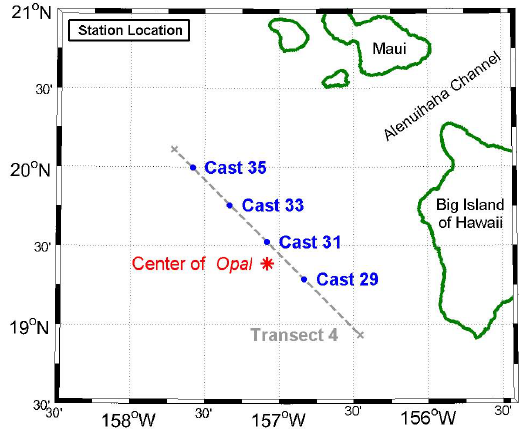
Fig. 2. Position of the four casts used in this study, and location of the estimated center of the eddy, Opal , at the time the casts were collected. The dashed line indicates the vertical section shown in Fig. 3. Notice that the position of the eddy center has changed from Fig. 1, due to Opal ’s migration (see Dickey et al., 2008; Nencioli et al., 2008).